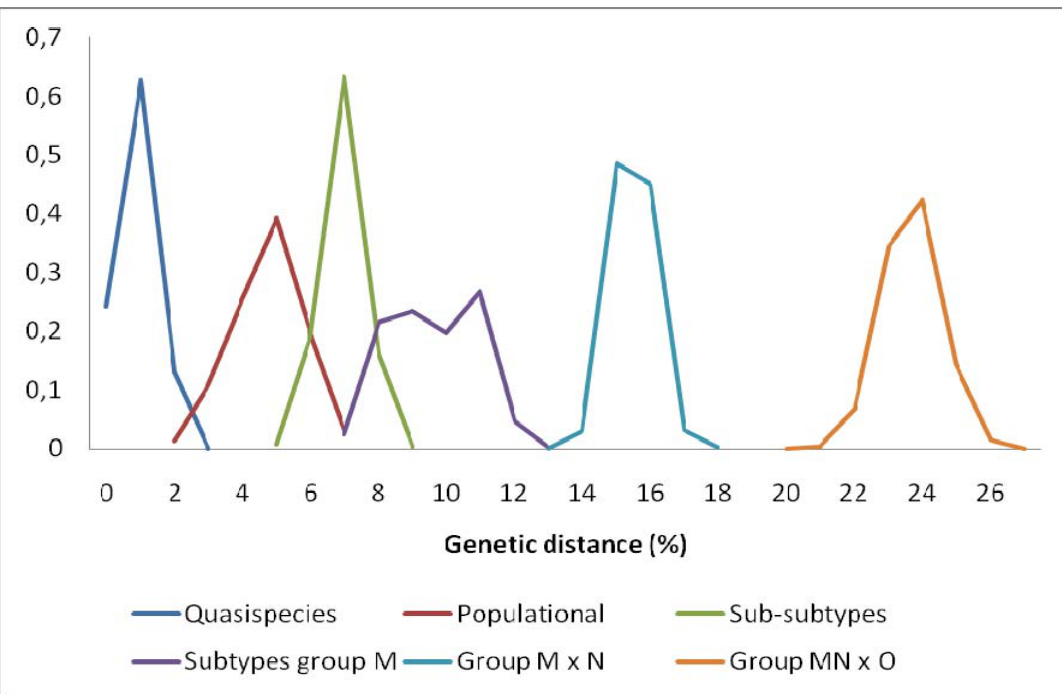
Figure 1. pol gene nucleotide distance within HIV groups, subtypes, sub-subtypes, populations and intrahost quasispecies. Estimates are presented as percentages of